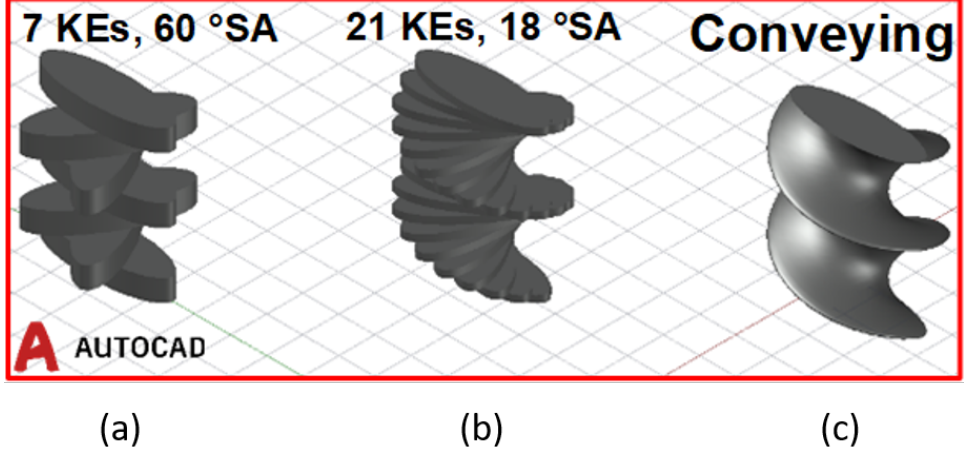
Figure 2. Schematic showing ( a ) kneading block of 7 elements each with thickness 3 units and SA 60 ◦ ; ( b ) kneading block of 21 elements each with thickness 1 unit and SA 18 ◦ ; and ( c ) conveying section of length 21 units and full turn angle 360 ◦